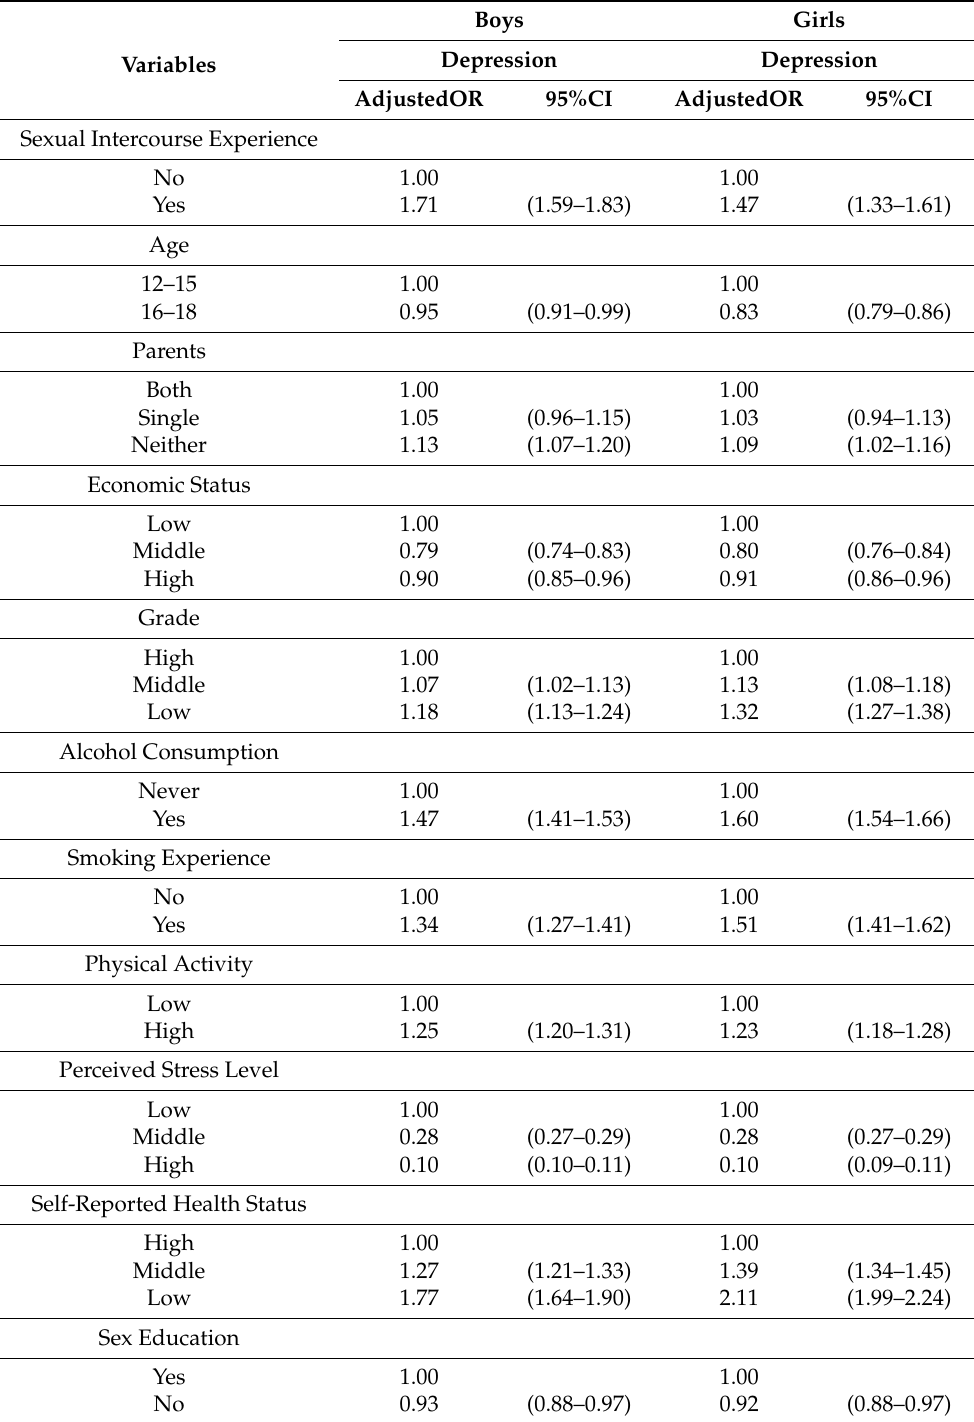
Table 2. Results of the multivariate logistic regression analysis of the association between sexual behavior and